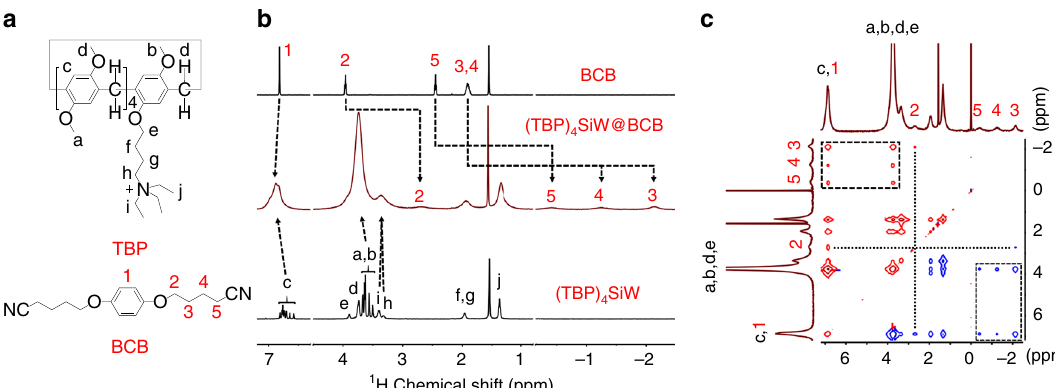
Fig. 2 Host-guest interaction between ionic complex and BCB. a Molecular structure of cationic host TBP and guest BCB. b Partial 1 H NMR spectra (CDCl 3 , 500 MHz, 25 °C) of BCB, (TBP) 4 SiW, and (TBP) 4 SiW@BCB (1:2). c Partial 2D NOESY spectrum (CDCl 3 , 500 MHz, 25 °C) of (TBP) 4 SiW@BCB (1:2). Source data are provided as a Source Data fi le.